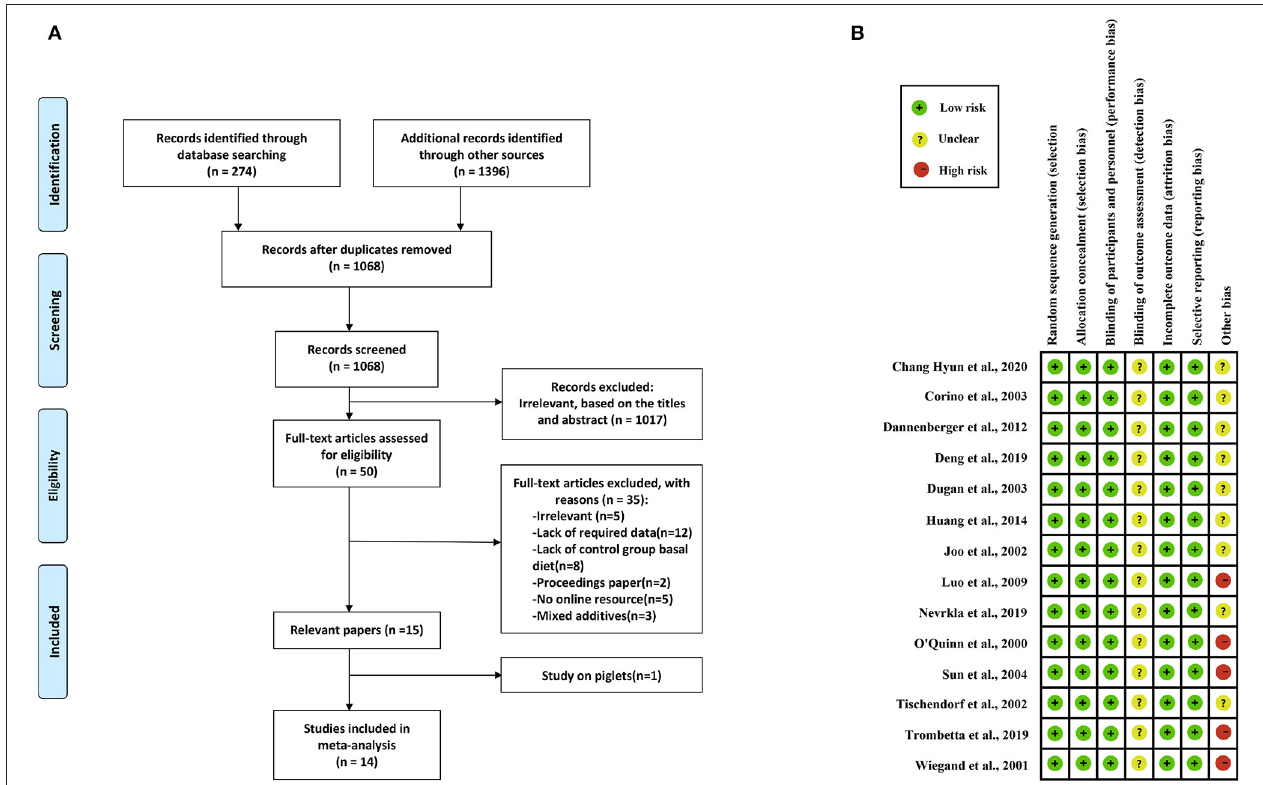
FIGURE 1 | Study selection process and quality assessment. (A) Flowchart for the study selection process. (B) Study quality